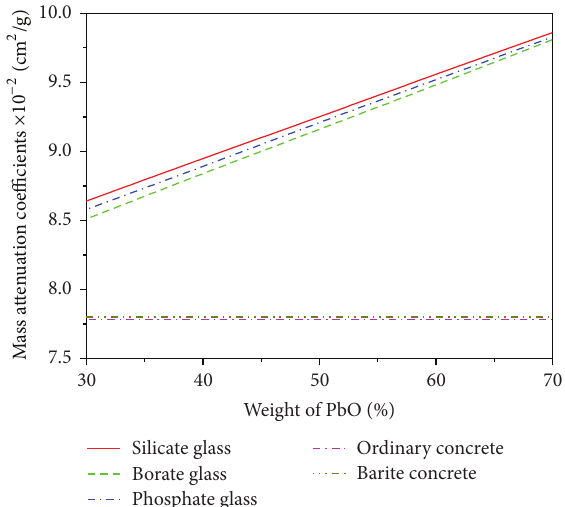
Figure 3: The mass attenuation coefficients of PbO containing sili- cate, borate, and phosphate glass systems at 662 keV in comparison with two shielding